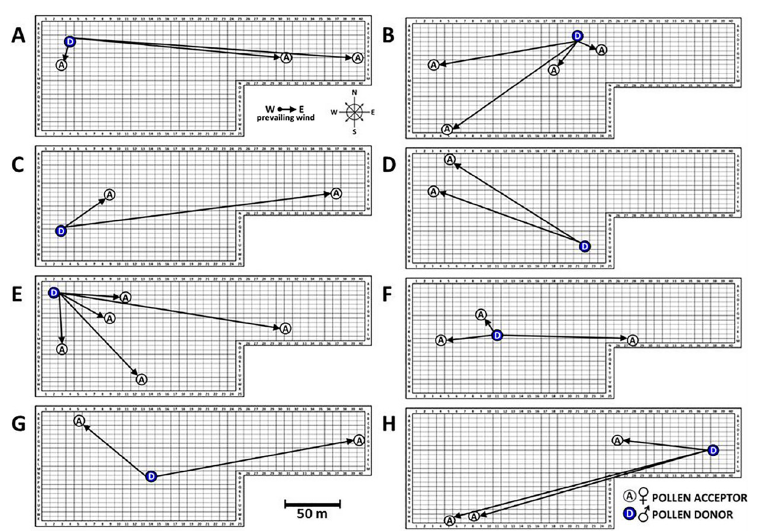
Fig 4. Selected single tree genotypes illustrate distance and angle of pollen flow in VO based on paternity analysis. (A) Clone 297: pollen donor for clone 288, 294, and 293. (B) Clone 139: pollen donor for 295, 263, 295, and 288. (C) Clone 192: pollen donor for clone 222 (upwind and downwind). (D) Clone 332: pollen donor for 293 and 288. (E ) Clone 289: pollen donor for 370, 298, 280, 353, and 298. (F) Clone 363: pollen donor for clone 280, 373, and 369. (G) Unknown genotype inside orchard pollinated 293 (upwind and downwind) (H) rootstock tree that pollinated ramets of clones 283, 263, and 295.